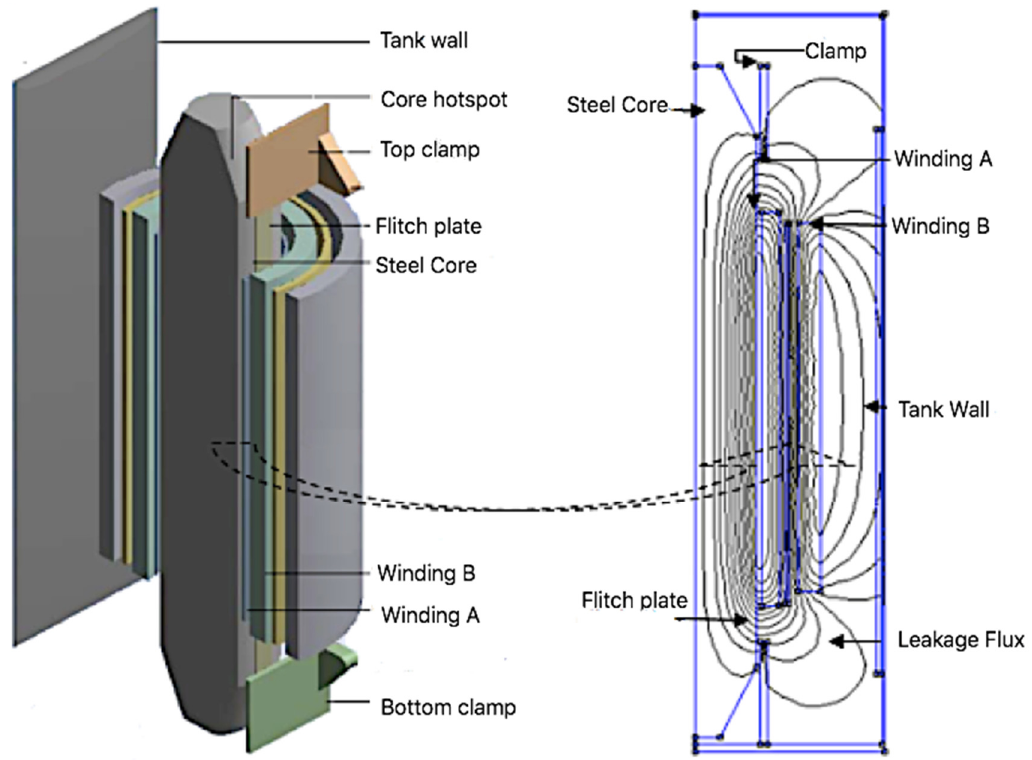
Figure 6. Magnetic field generation in a